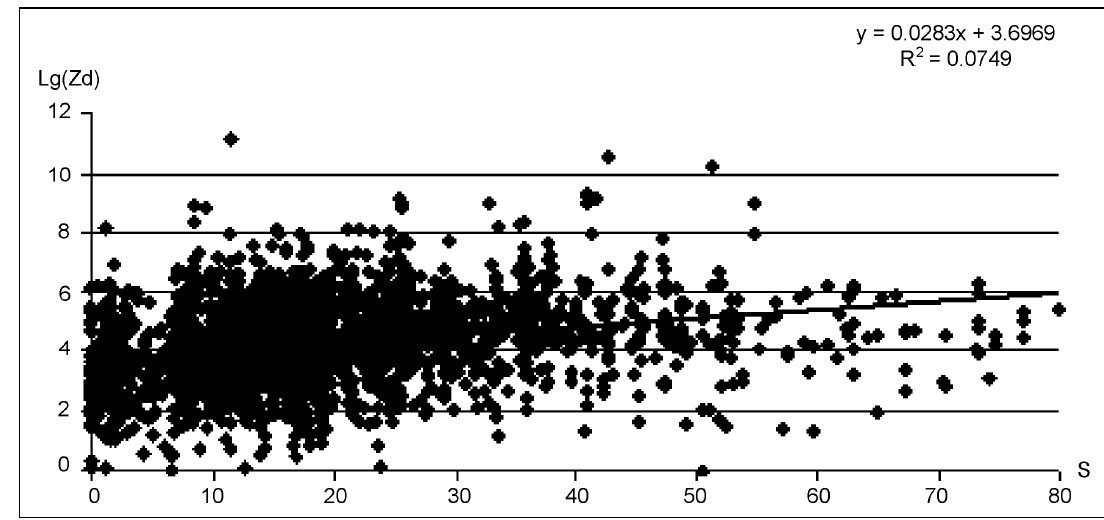
Fig. 4. Linear regression between common logarithm of additive contamination Zd and sensitivity to chemical pollution